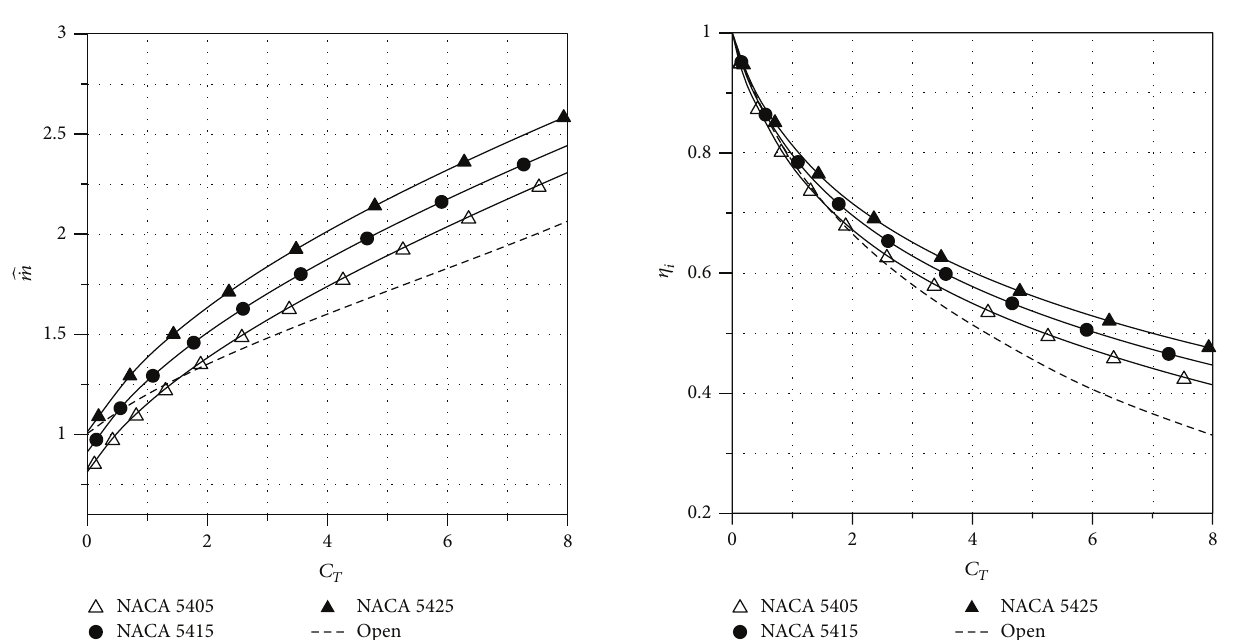
Figure6:Effectsoftheprofilethicknessonthepropulsiveefficiency.